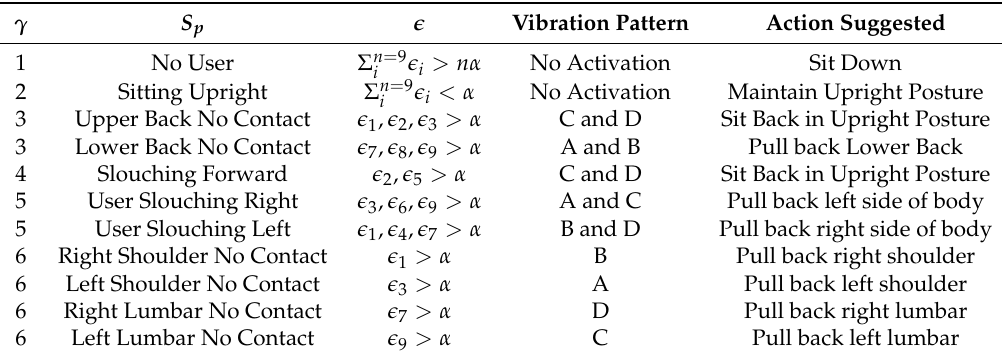
Table 1. Posture Classification and Haptic Feedback